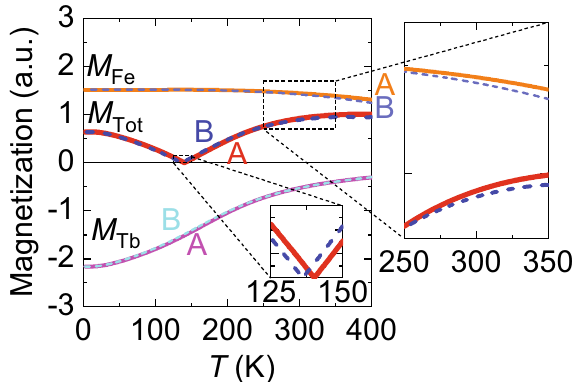
Figure 6. Simulated magnetization dependence on T for M Fe , M Tb and M Tot = M Fe + M Tb . Parameters used for calculating the curve A are M Fe (0)/ n Fe = 2 µ B , M Tb (0)/ n Tb = 9 µ B , w FeFe = 468, w FeTb = 12 and w TbTb = 28. Parameters w FeFe , w FeTb , and w TbTb used for curves denoted as B are 8% smaller, 9% larger, and 8% smaller compared with those for A, respectively. Insets are enlarged views around T comp and the room